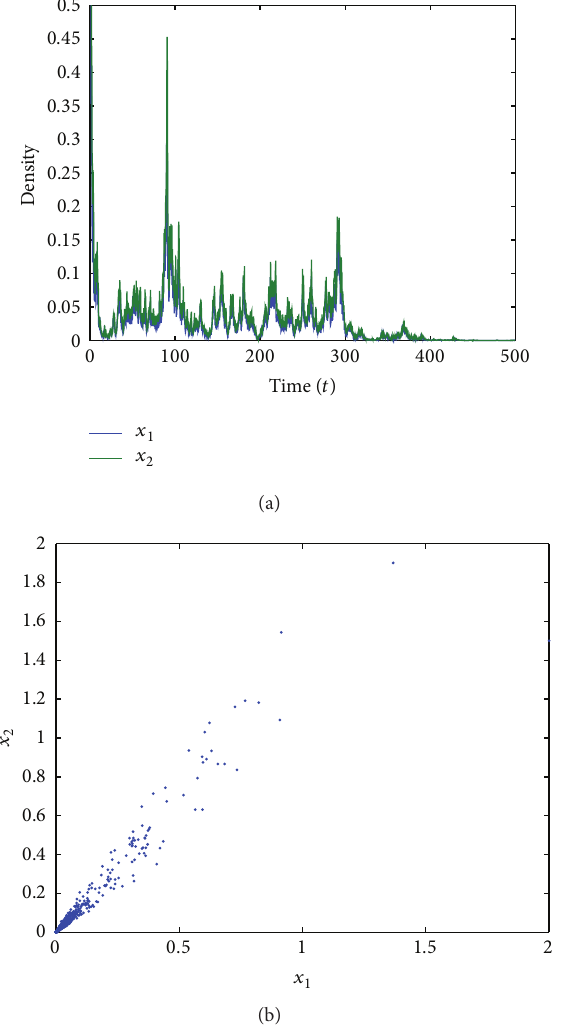
Figure 3: Numerical simulations of Example 10. In this example, we choose 𝜀 21 sufficiently large such that conditions in Theorem 3 are destroyed which show the destabilizing effect of large diffusion